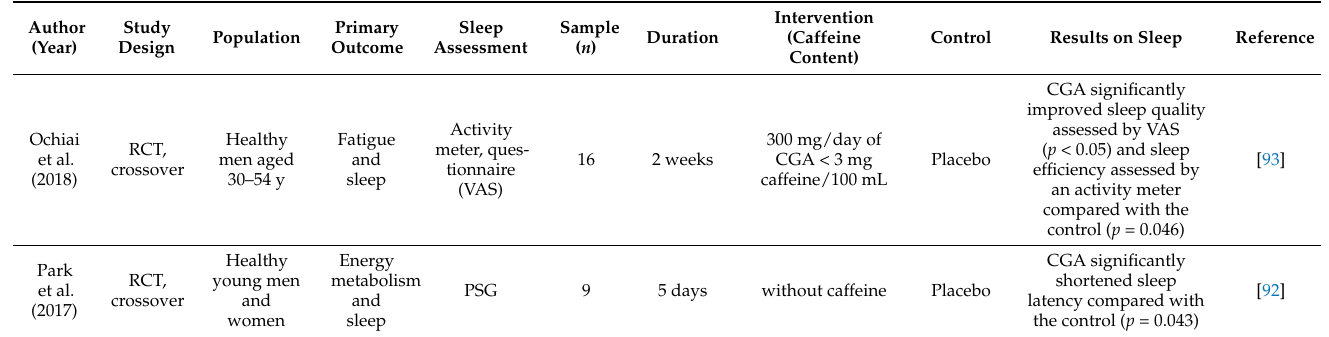
Table 1. Summary of human clinical studies assessing the association between sleep and chlorogenic acid